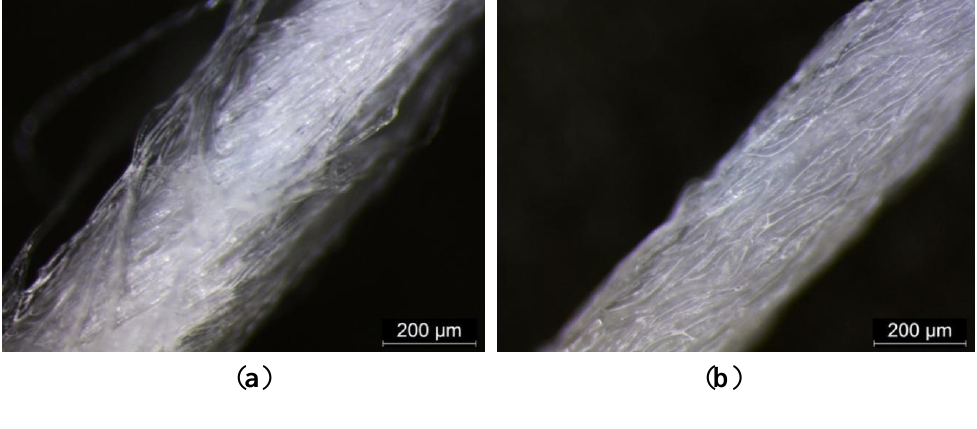
Figure 3. Microscopic view of ( a ) CH; ( b ) MCG; ( c ) F and ( d ) MF yarn wetted with D.I.